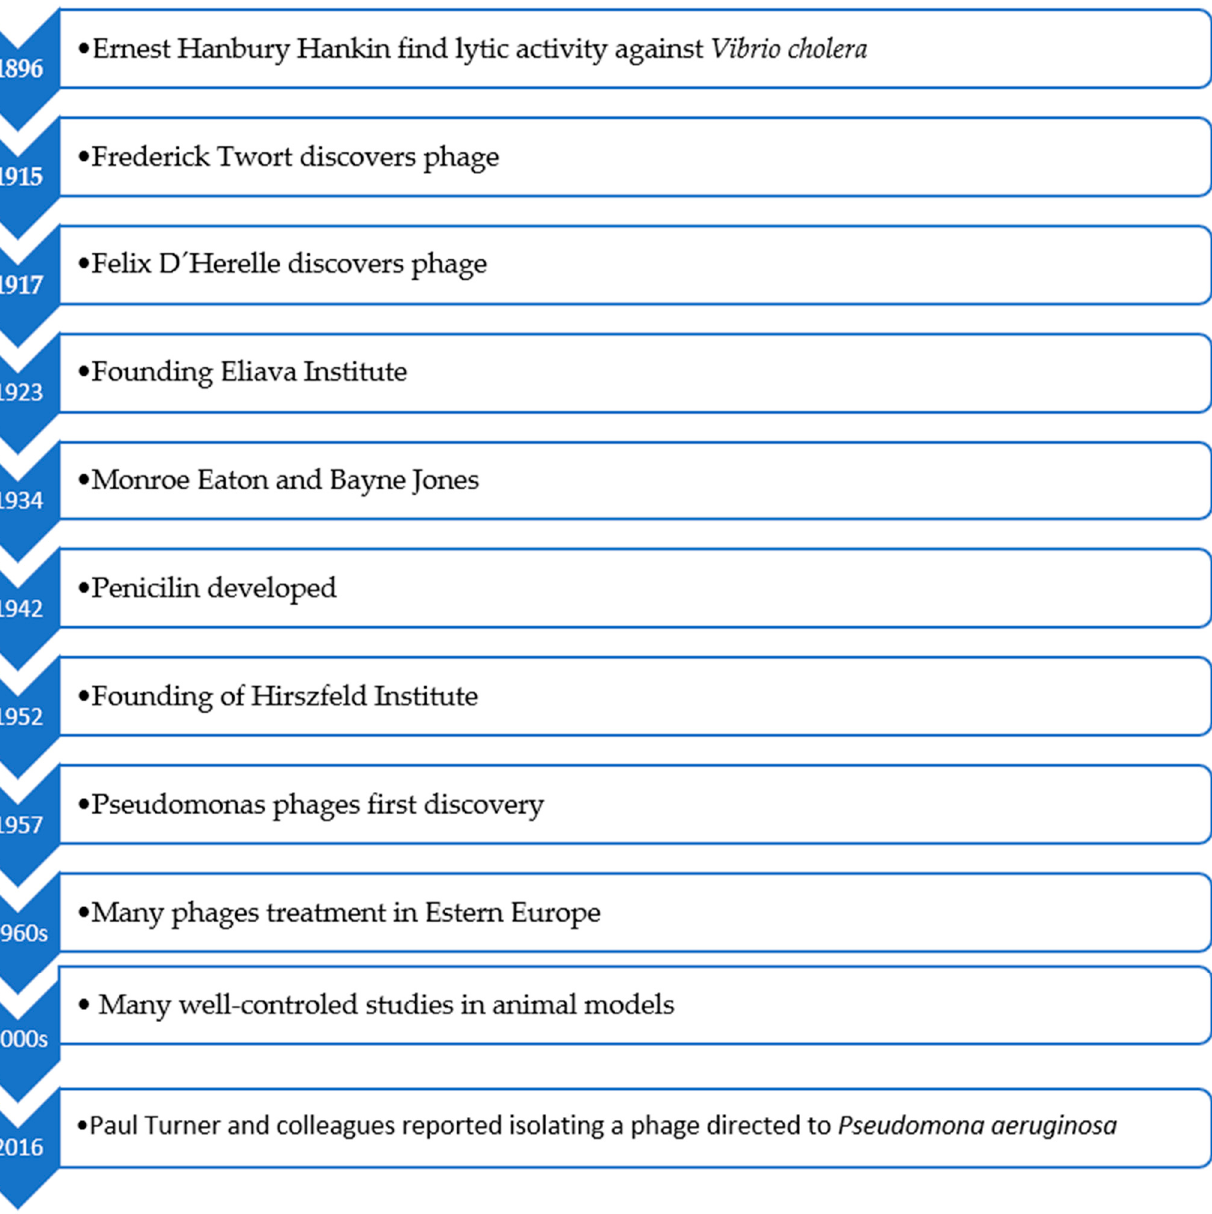
Figure 1. Phage therapy timeline. Adapted from Green et al. [20].